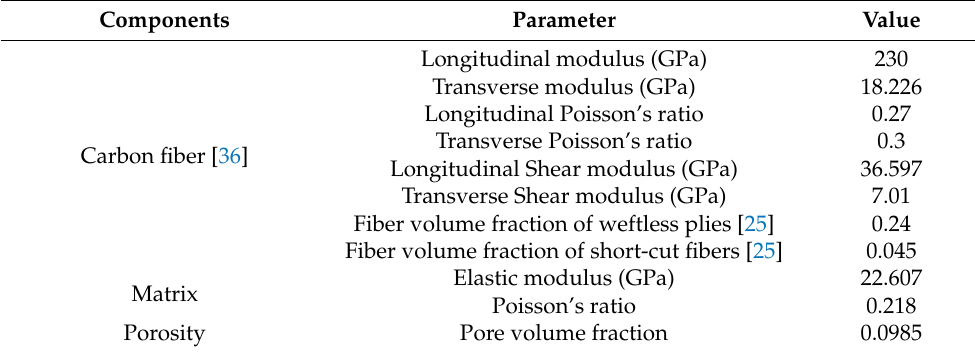
Table 1. Material parameters.